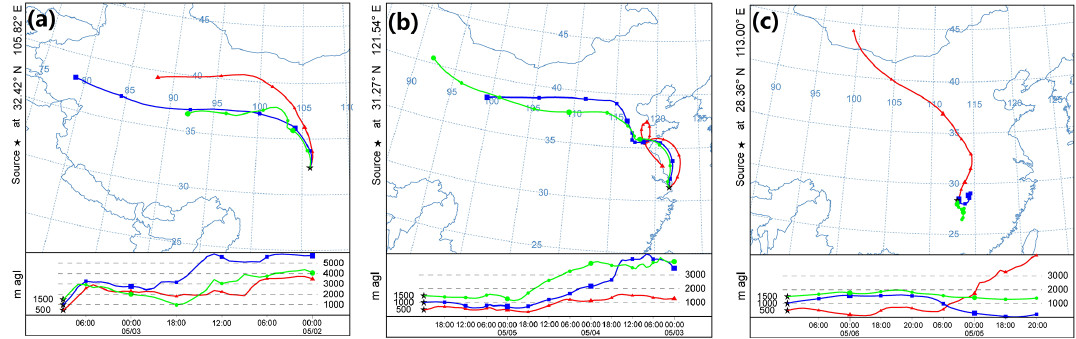
Figure 12. Backward trajectories derived from the HYSPLIT model at different altitude levels (500, 1000, and 1500m) at (a) GYS on 3 May, (b) SHS on 6 May, and (c) CSS on 6 May 2017.